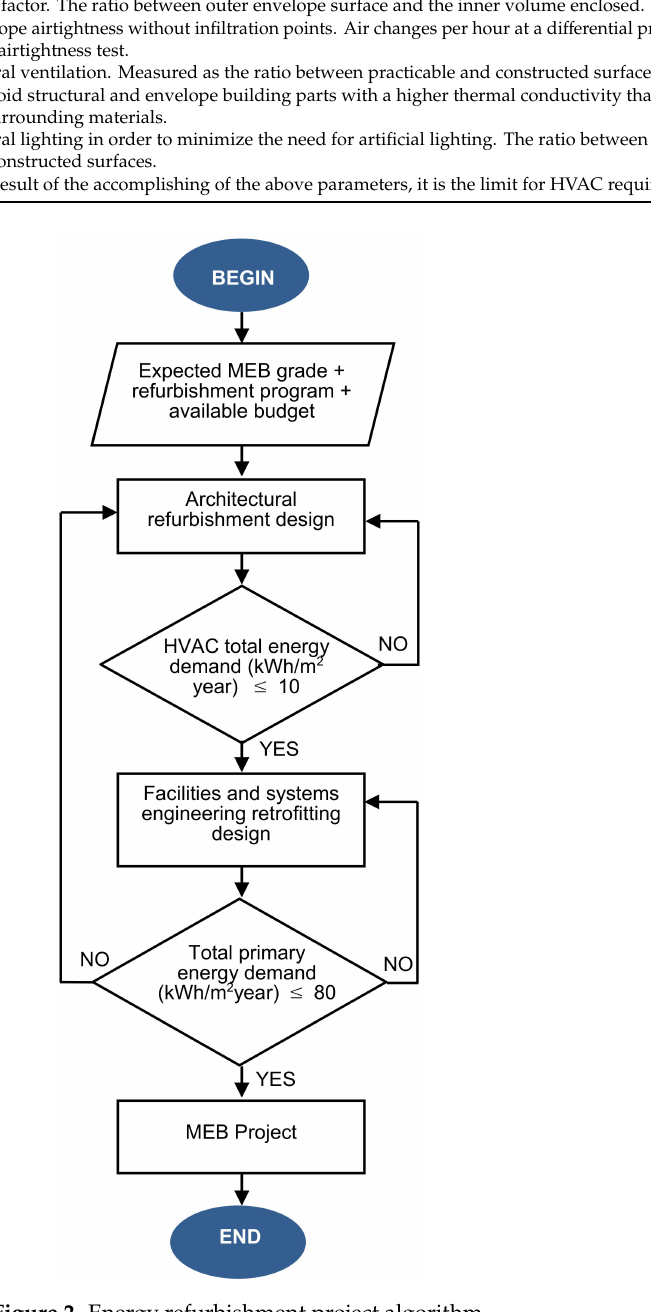
Figure 2. Energy refurbishment project